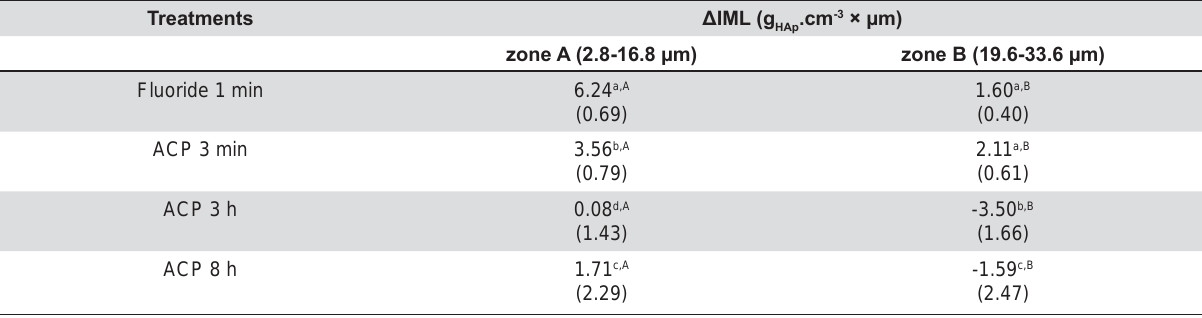
Table 2- (cid:3)(cid:48)(cid:72)(cid:68)(cid:81)(cid:3)(cid:89)(cid:68)(cid:79)(cid:88)(cid:72)(cid:86)(cid:3)(cid:11)(cid:54)(cid:39)(cid:12)(cid:3)(cid:82)(cid:73)(cid:3)(cid:76)(cid:81)(cid:87)(cid:72)(cid:74)(cid:85)(cid:68)(cid:87)(cid:72)(cid:71)(cid:3)(cid:82)(cid:73)(cid:3)(cid:71)(cid:76)(cid:73)(cid:73)(cid:72)(cid:85)(cid:72)(cid:81)(cid:87)(cid:76)(cid:68)(cid:79)(cid:3)(cid:83)(cid:85)(cid:82)(cid:191)(cid:79)(cid:72)(cid:86)(cid:3)(cid:11)(cid:507)(cid:44)(cid:48)(cid:47)(cid:12)(cid:3)(cid:70)(cid:68)(cid:79)(cid:70)(cid:88)(cid:79)(cid:68)(cid:87)(cid:72)(cid:71)(cid:3)(cid:73)(cid:82)(cid:85)(cid:3)(cid:87)(cid:90)(cid:82)(cid:3)(cid:93)(cid:82)(cid:81)(cid:72)(cid:86)(cid:3)(cid:11)(cid:41)(cid:76)(cid:74)(cid:88)(cid:85)(cid:72)(cid:3)(cid:20)(cid:71)(cid:12)(cid:3)(cid:76)(cid:81)(cid:3)(cid:87)(cid:75)(cid:72)(cid:3)(cid:72)(cid:81)(cid:68)(cid:80)(cid:72)(cid:79)(cid:3)(cid:79)(cid:72)(cid:86)(cid:76)(cid:82)(cid:81)(cid:86)(cid:3)(cid:68)(cid:70)(cid:70)(cid:82)(cid:85)(cid:71)(cid:76)(cid:81)(cid:74)(cid:3) to the treatments